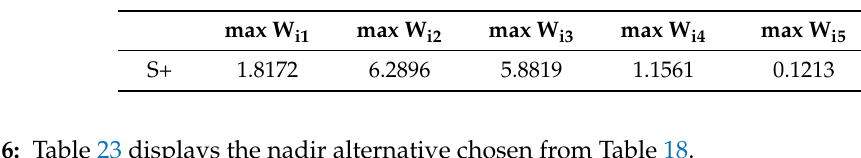
Table 22. Table of ideal issue.